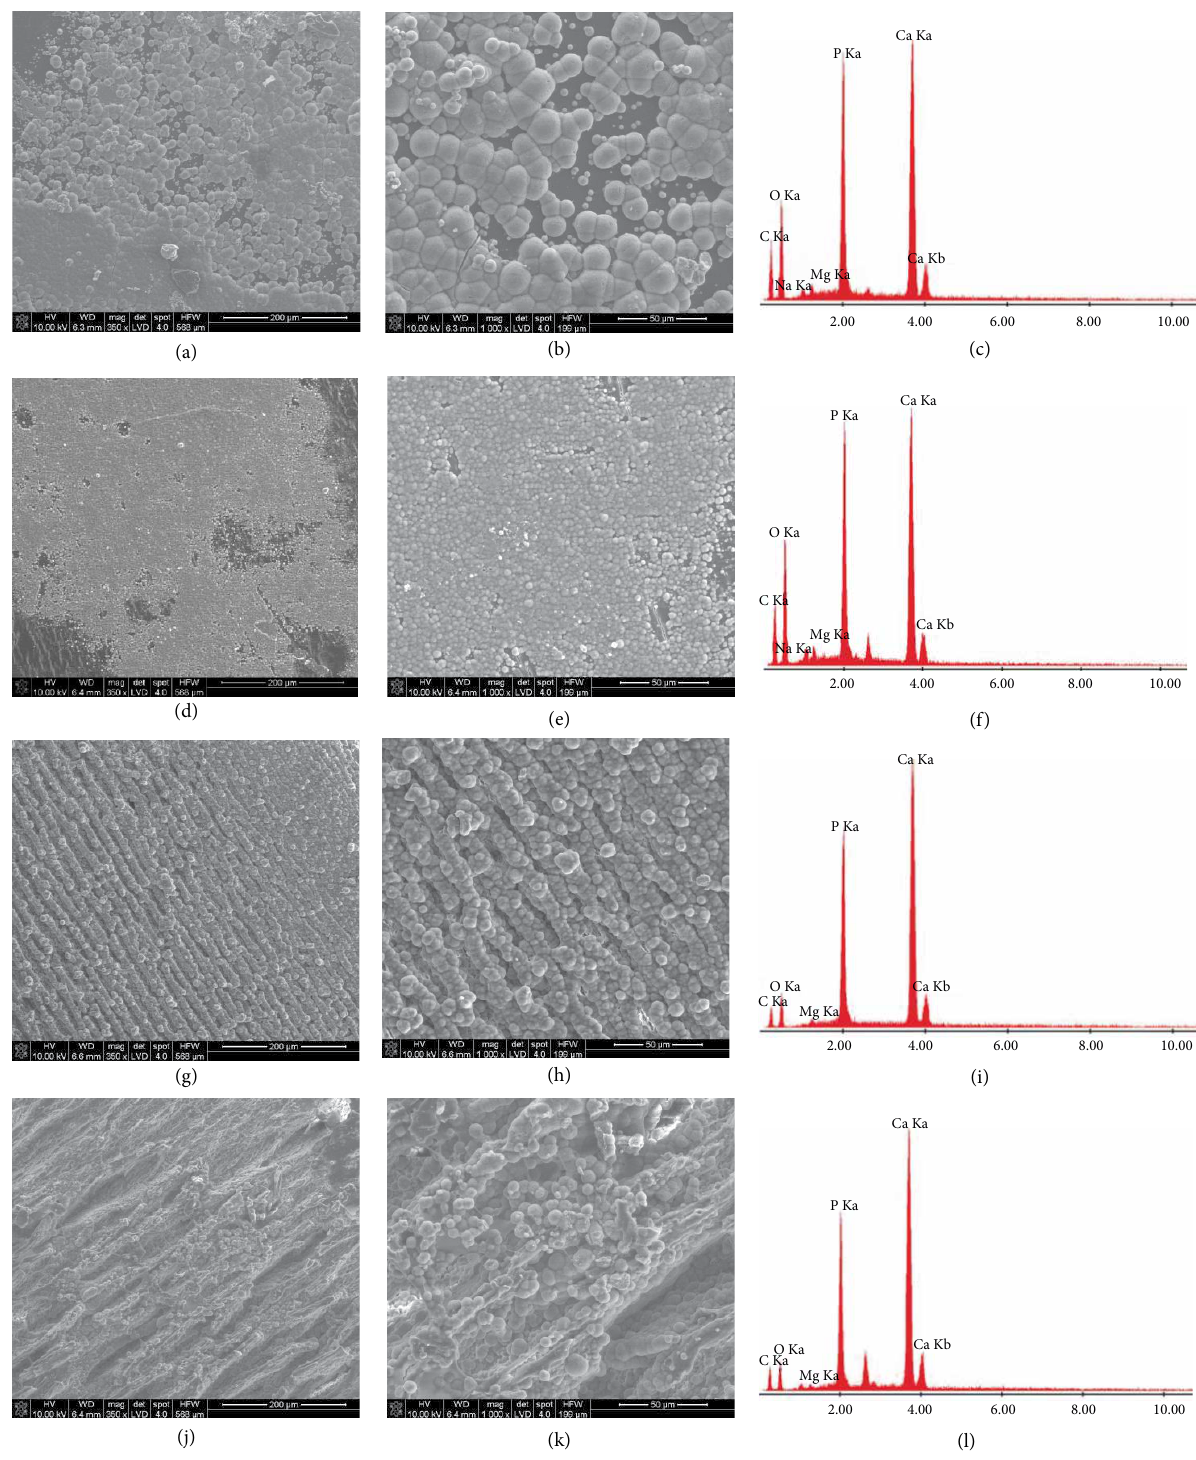
Figure 12: SEM/EDX results of POM/HA- g -PEG composites after incubation in SBF: (a–c) POM, (d–f) 5.0% HA- g -PEG 600, (g–i) 5.0% HA- g -PEG 2000, and (j–l) 5.0% HA- g -PEG